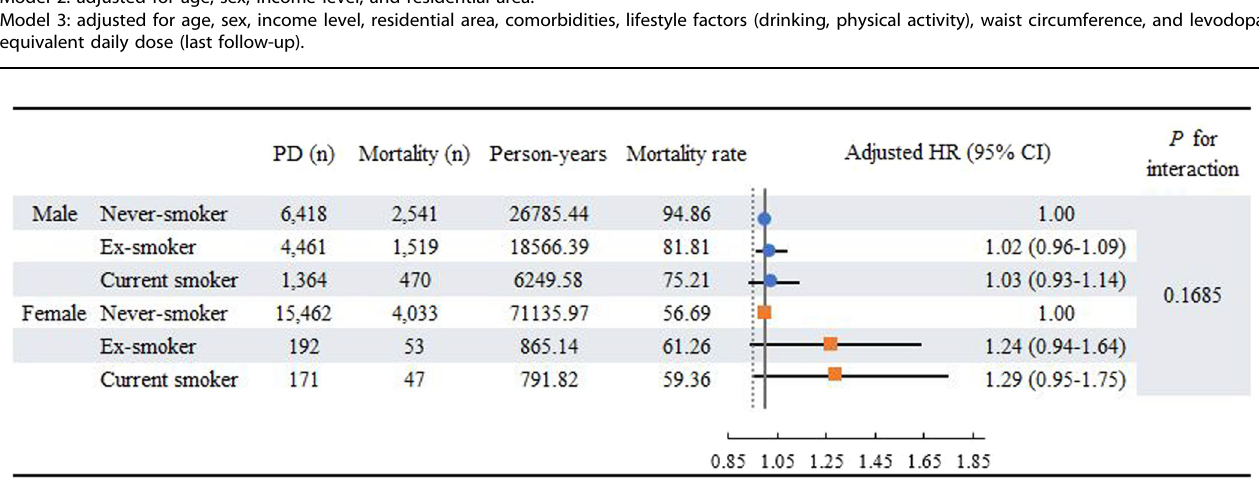
Fig. 1 Adjusted hazard ratios on the risk of all-cause mortality in patients with Parkinson ’ s disease according to smoking status strati fi ed by sex. Association between smoking status and all-cause mortality in Parkinson ’ s disease was evaluated strati fi ed by sex using Cox proportional hazard regression analysis. In the subgroup analysis by sex, there was no signi fi cant association between smoking status and all- cause mortality in either sex. Fig. 2. In total, 304 studies were identi fi ed during the initial search. After duplicates were removed, 253 studies remained. Based on the screening of titles and abstracts, 245 studies were discarded.